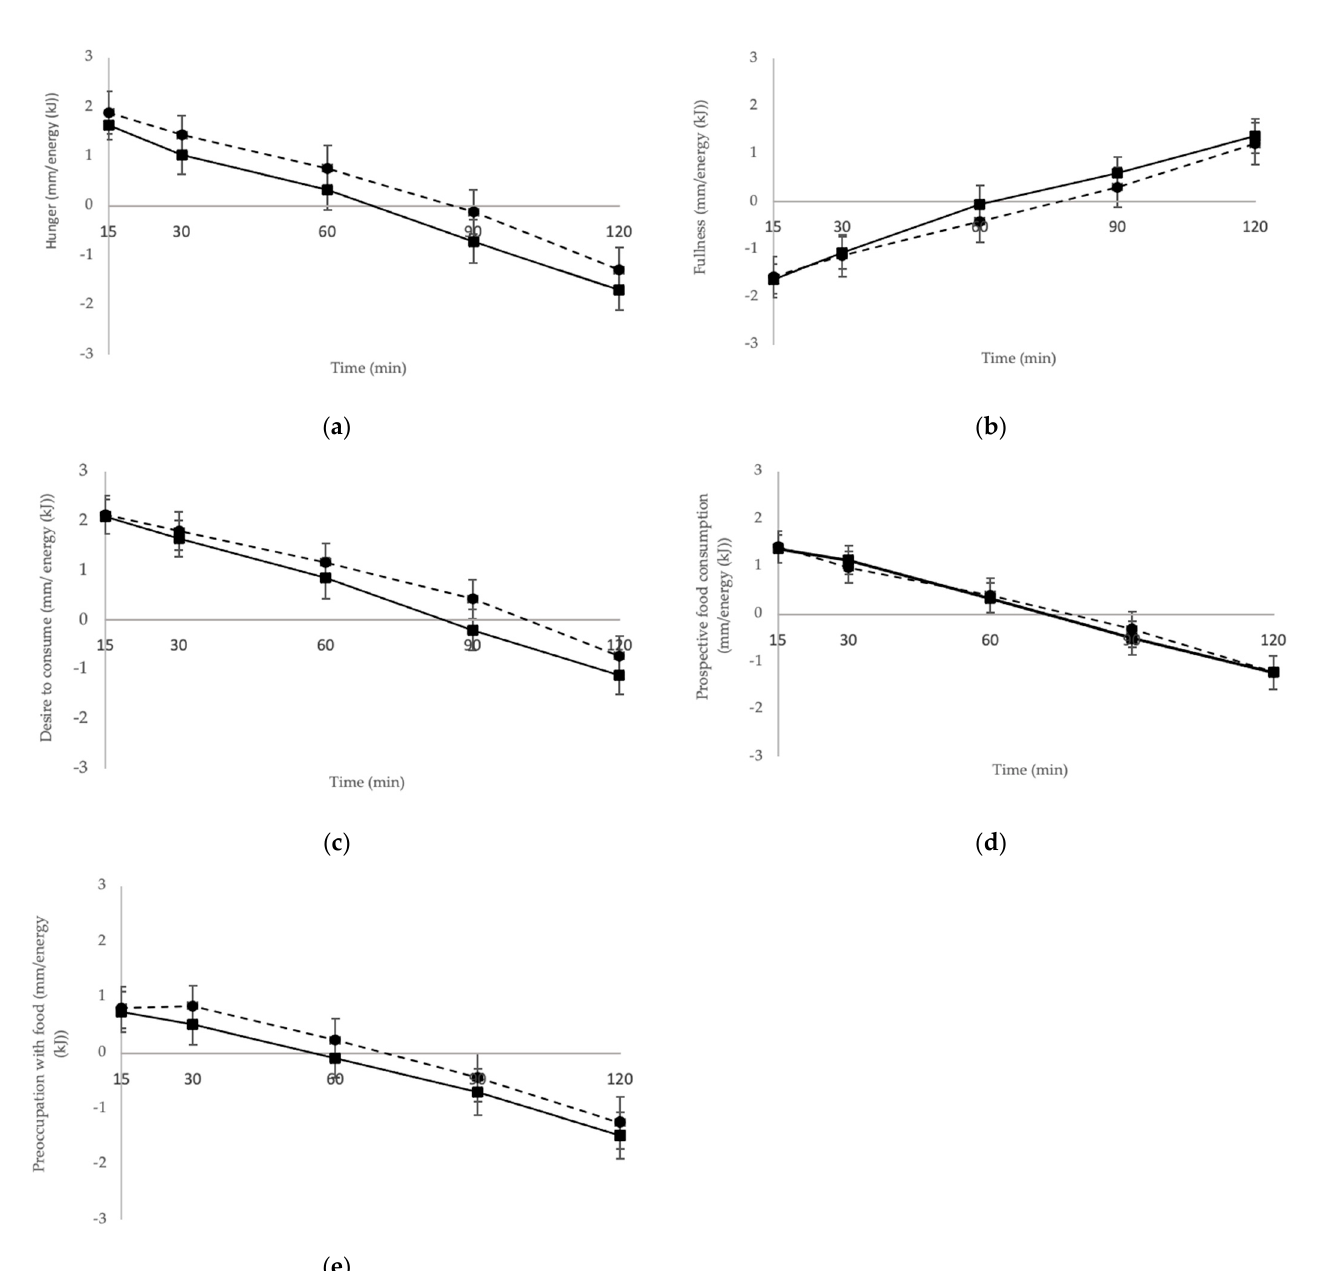
Figure 4. Mean (95% CI) satiety quotient (using Atwater factor energy) immediately after consuming the snack to 120 min for: ( a ) Hunger; ( b ) fullness; ( c ) desire to consume; ( d ) prospective food consumption; ( e ) preoccupation with food. Solid line with ■ , almonds; dashed line with ● , biscuits.